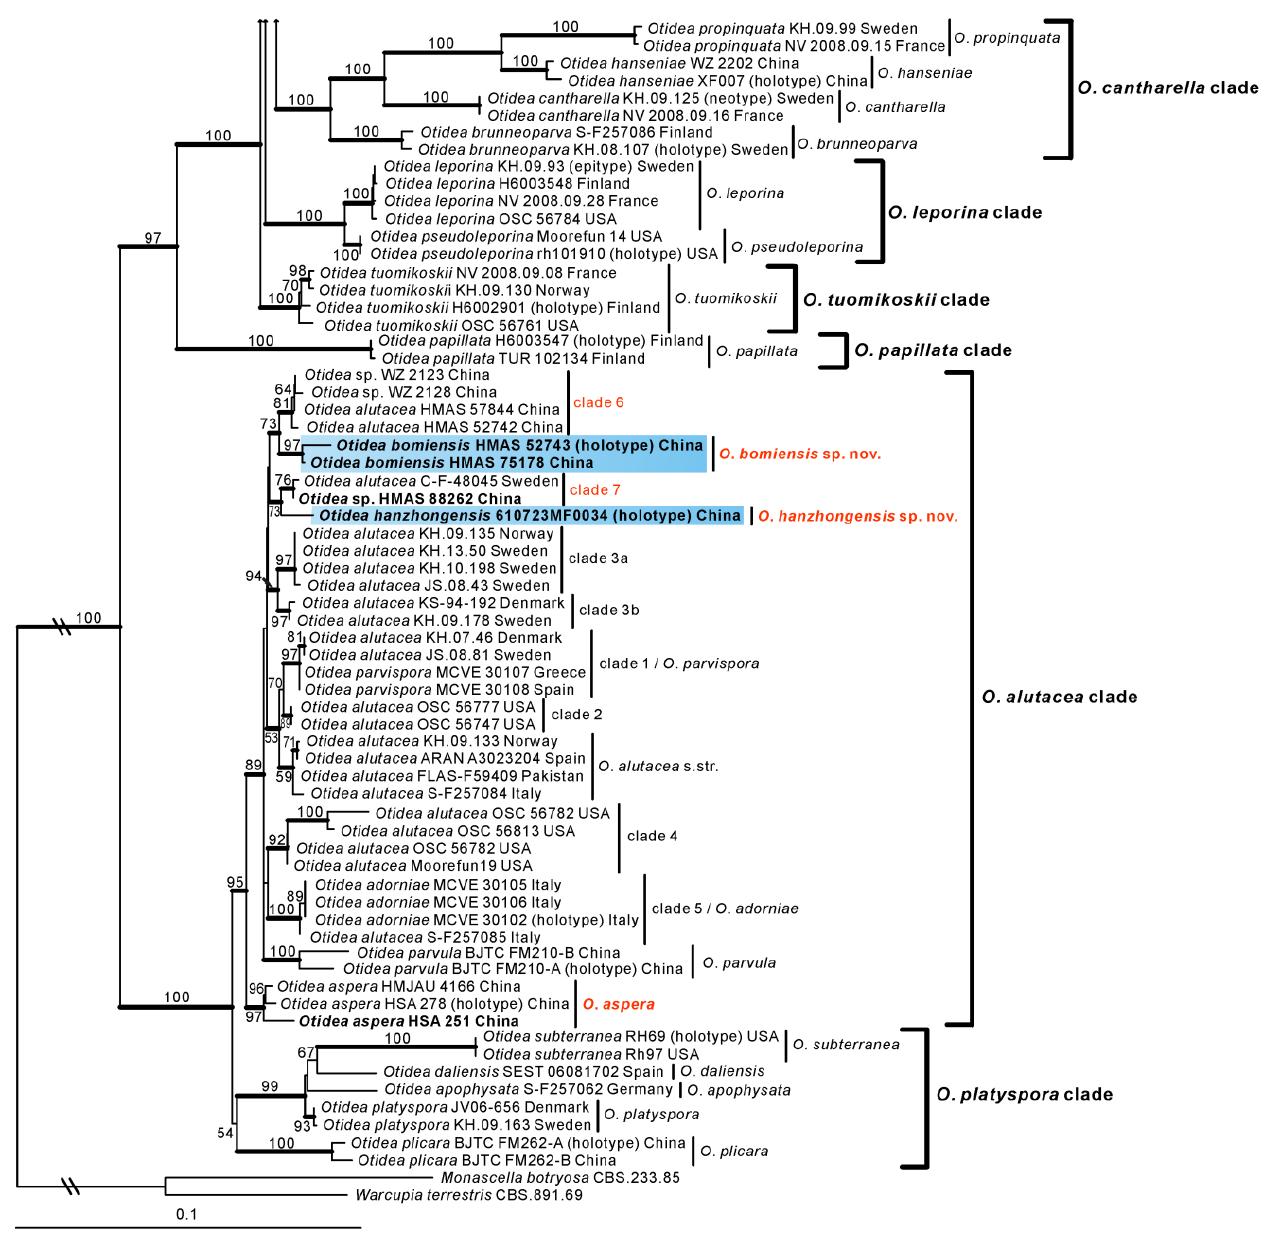
Figure 1. Phylogeny of Otidea derived from maximum likelihood analyses of the combined (LSU- tef1- α - rpb2) dataset. Monascella botryosa and Warcupia terrestris were used to root the tree as outgroups. Maximum likelihood bootstrap support (BS ≥ 50%) is shown on the nodes. Branches with Bayesian posterior probabilities (PP) ≥ 0.95 and new sequences are in bold.